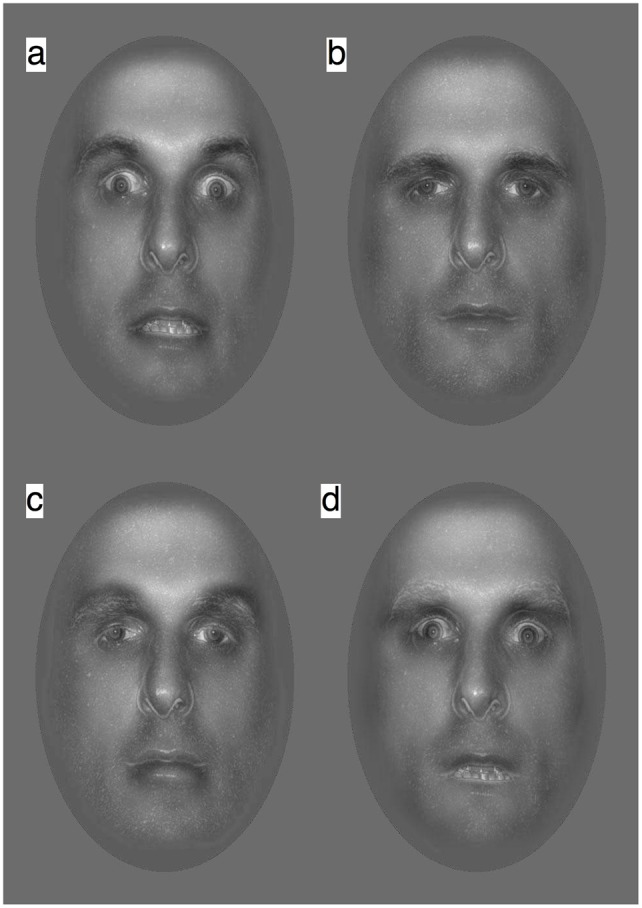
Hybrid face stimuli were created by recombining the LSF and HSF components of fearful (F) and neutral (N) faces into hybrids as: (a) FLSF–FHSF
(b) NLSF–NHSF
(c) FLSF–NHSF, and (d) NLSF–FHSF.